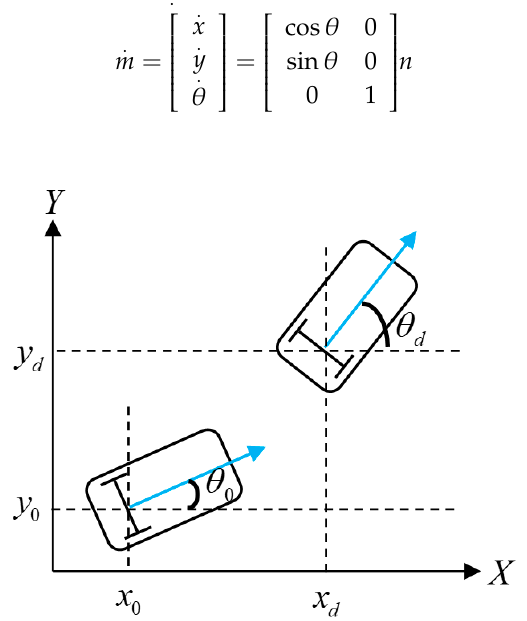
Figure 8. Simplified Path Tracking Model.